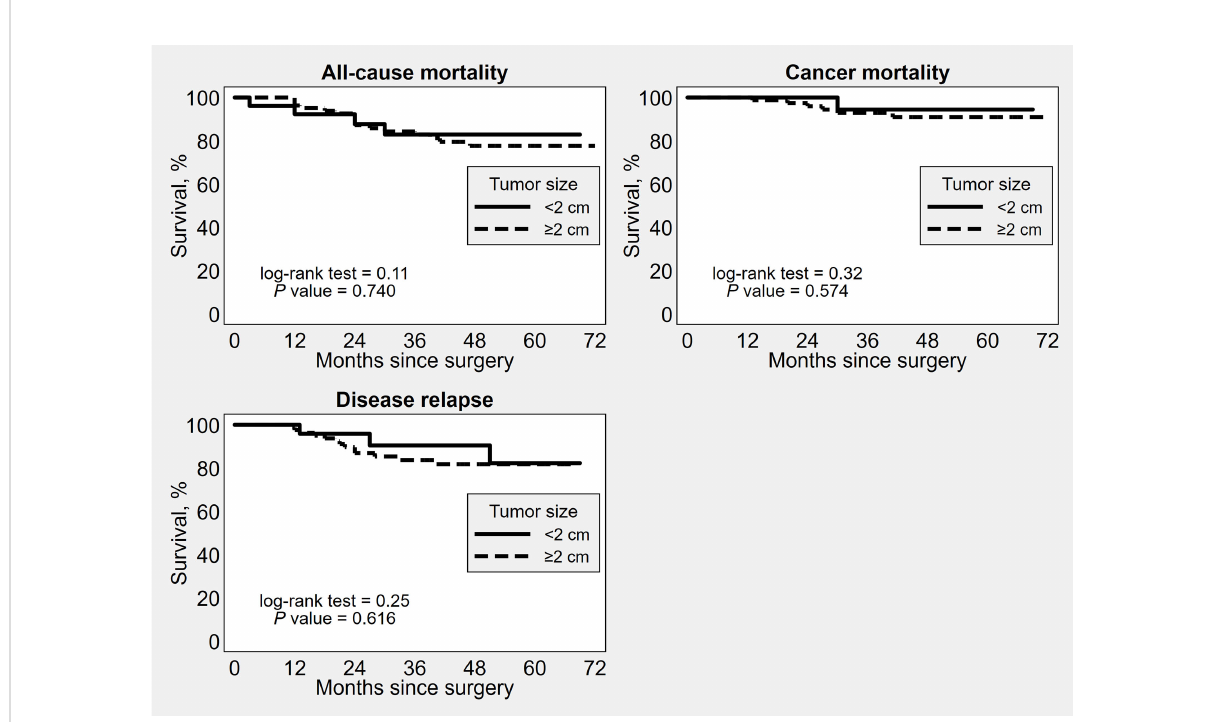
FIGURE 1 Kaplan – Meier survival estimates of time to all-cause mortality, cancer mortality and disease recurrence after surgery, by 2 cm tumor diameter